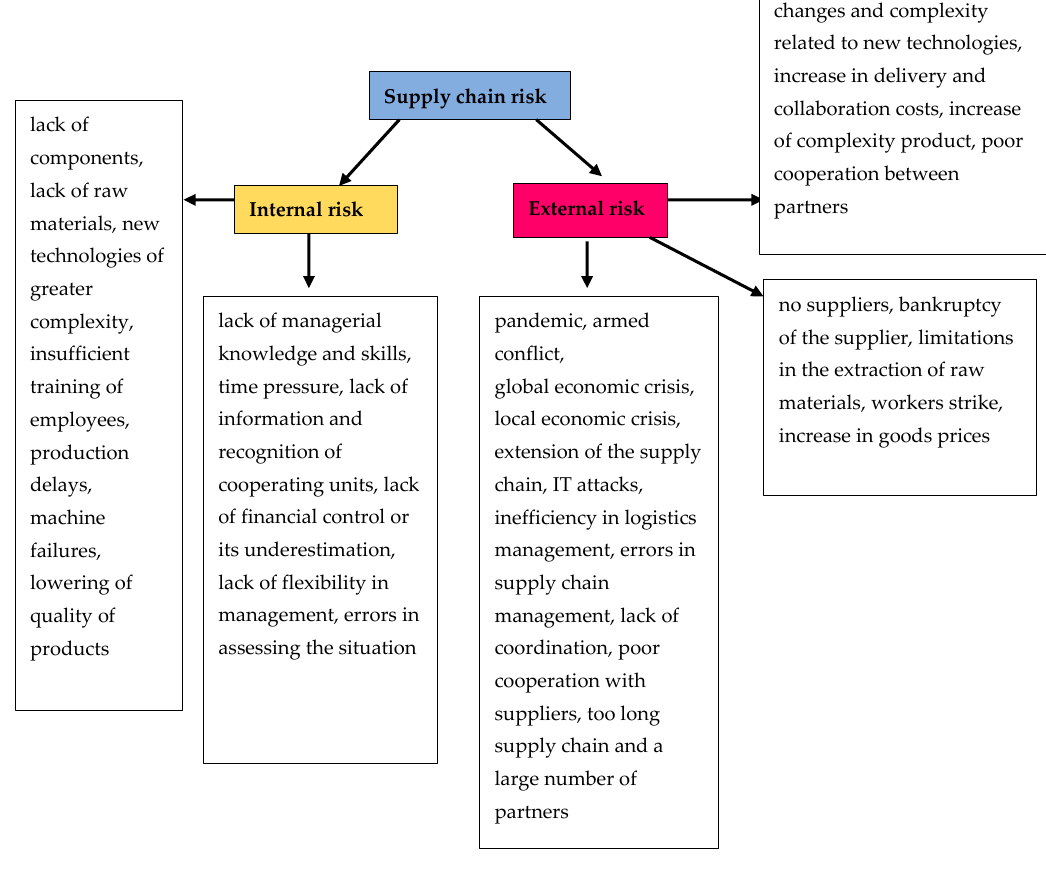
Figure 1. Scheme of risk sharing in supply chains into external and internal risk. Source: (own Fig. 1. Scheme of risk sharing in supply chains into external and internal risk.